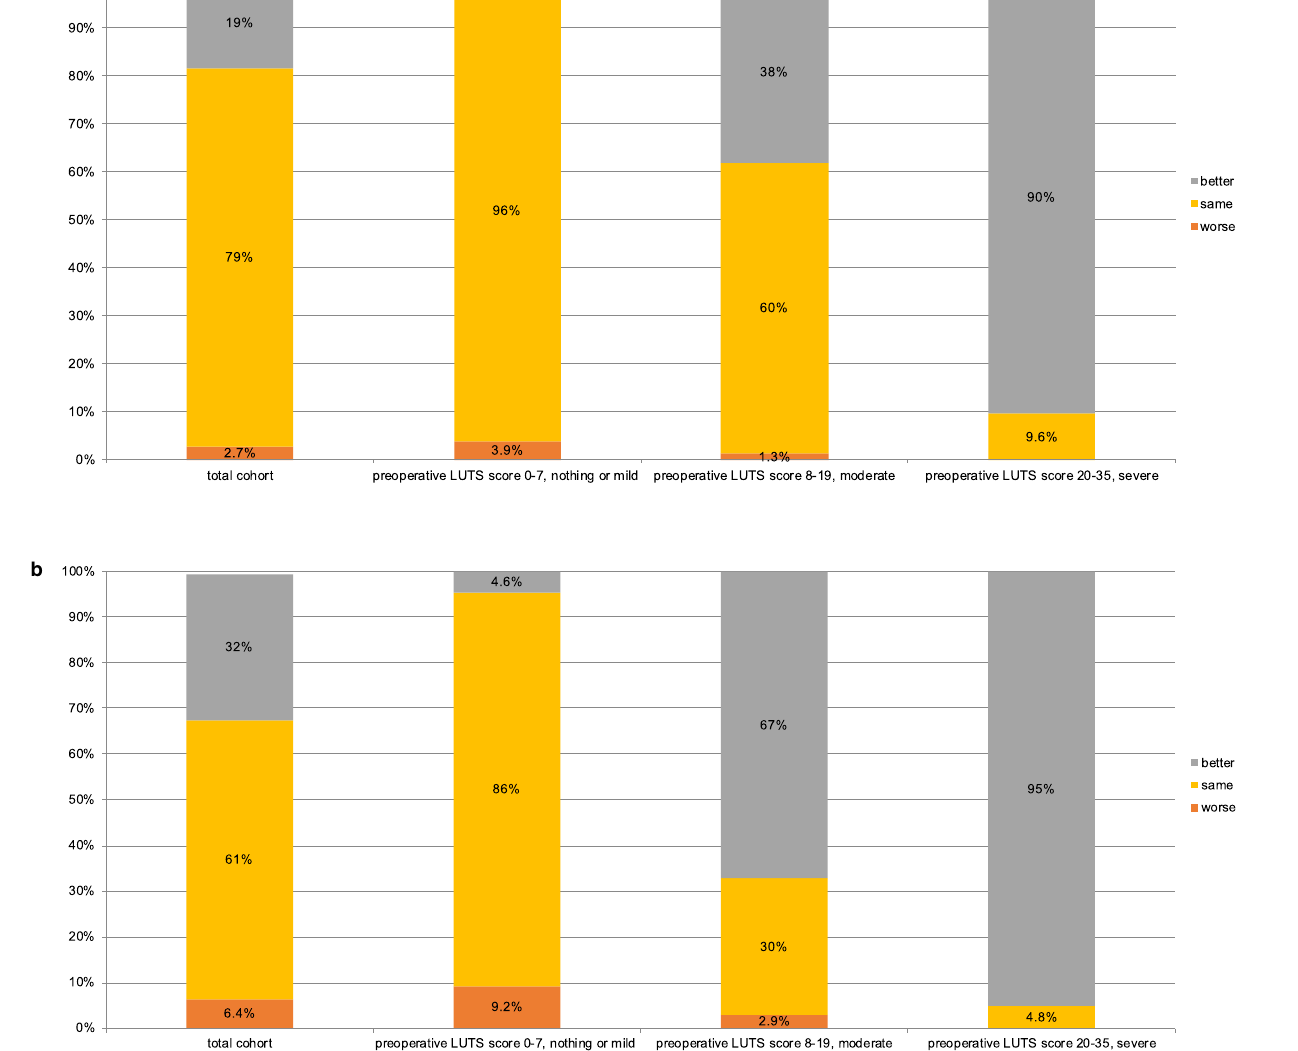
Figure 1. ( a ) "Marked clinically important differences 12 months after robot-assisted radical prostatectomy, defined as a change of at least 8 points in the International Prostate Symptom Score, in the overall cohort and stratified according to preoperative lower urinary tract symptoms burden, nothing or mild vs. moderate vs. severe". ( b ) "Moderate clinically important differences 12 months after robot-assisted radical prostatectomy, defined as a change of at least 5 points in the International Prostate Symptom Score, in the overall cohort and stratified according to preoperative lower urinary tract symptoms burden, nothing or mild vs. moderate vs.